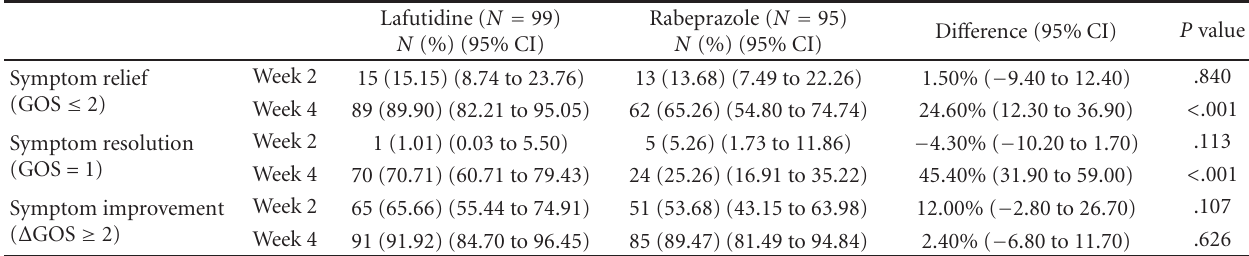
Table 2: Proportion of patients achieving symptom relief (GOS ≤ 2), symptom resolution (GOS = 1), and symptom improvement ( Δ GOS ≥ 2).